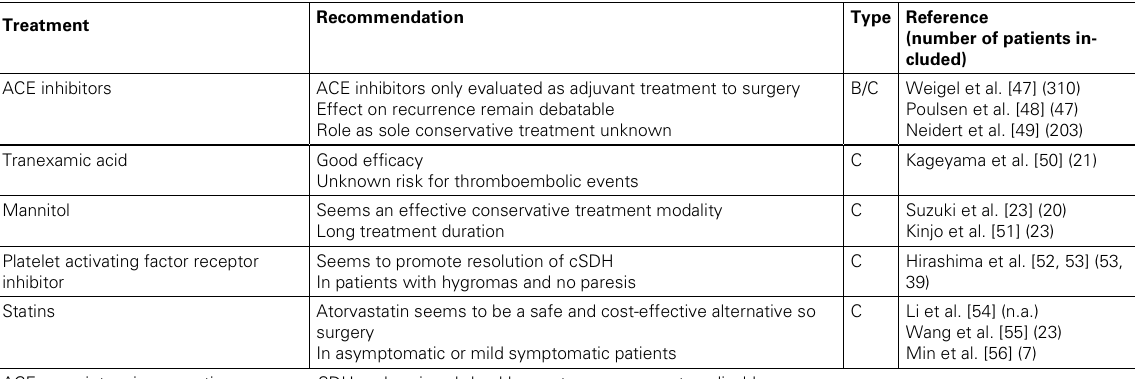
Table 4: Studies evaluating the treatment of cSDH with various conservative treatment modalities: results and recommendations.